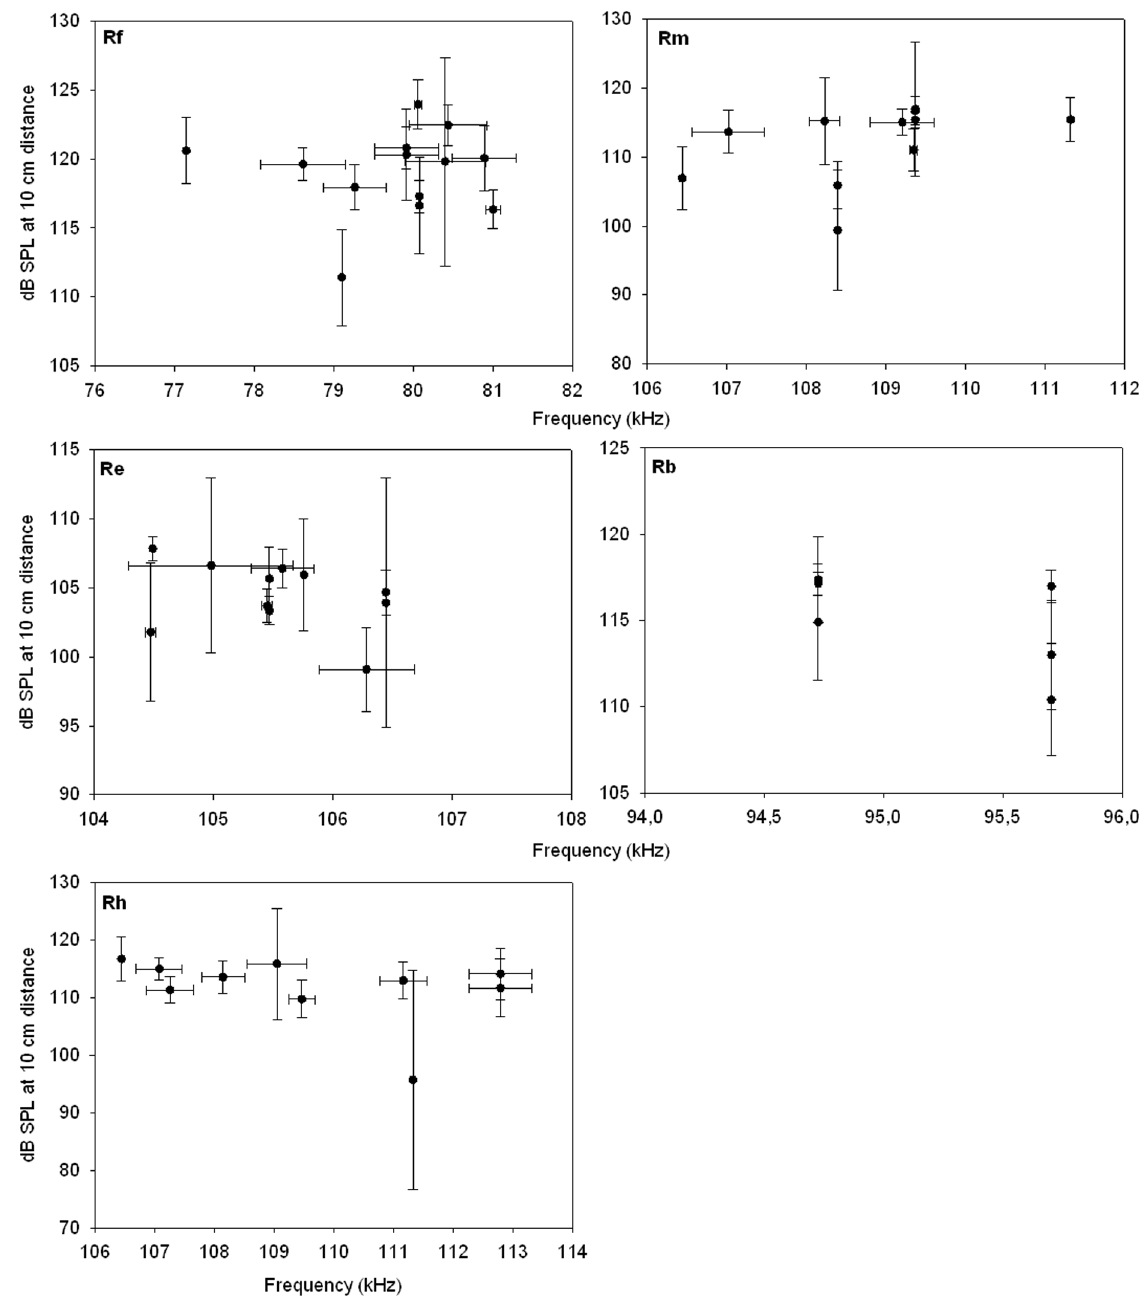
Figure 3. Intraspecific call intensity relations and intra-individual variation. Averaged call intensities of the six highest intensities of each individual (in dB SPL; calculated for 10cm distance to the bats’ nose) for individual R. ferrumequinum (Rf, N=12), R. blasii (Rb, N=6), R. mehelyi (Rm, N=11), R. euryale (Re, N=12) and R. hipposideros (Rh, N=10) are plotted against the corresponding averaged peak echolocation call frequencies. Error bars show the corresponding standard